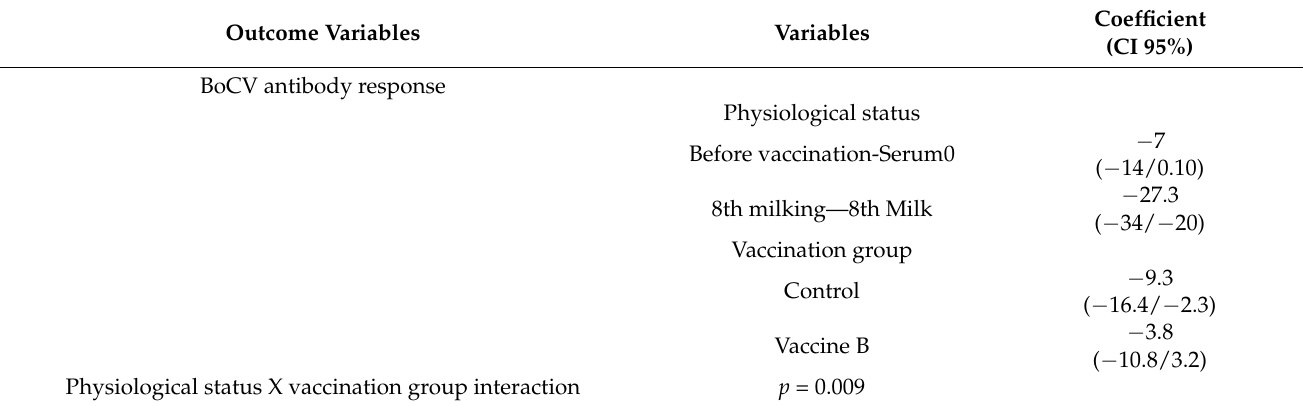
Table 2. Multivariable analysis for BoCV, BoRV and ETEC antibody response in cows using physiological status (before vaccination-Serum0, delivery-SerumPart and 8th milking-8th Milk) and vaccination group (A, B or control) as explanatory variables with cow as a random effect. The reference value for physiological status and vaccination group in the multivariable analysis were delivery—SerumPart and vaccine A, respectively; CI = Confidence Interval